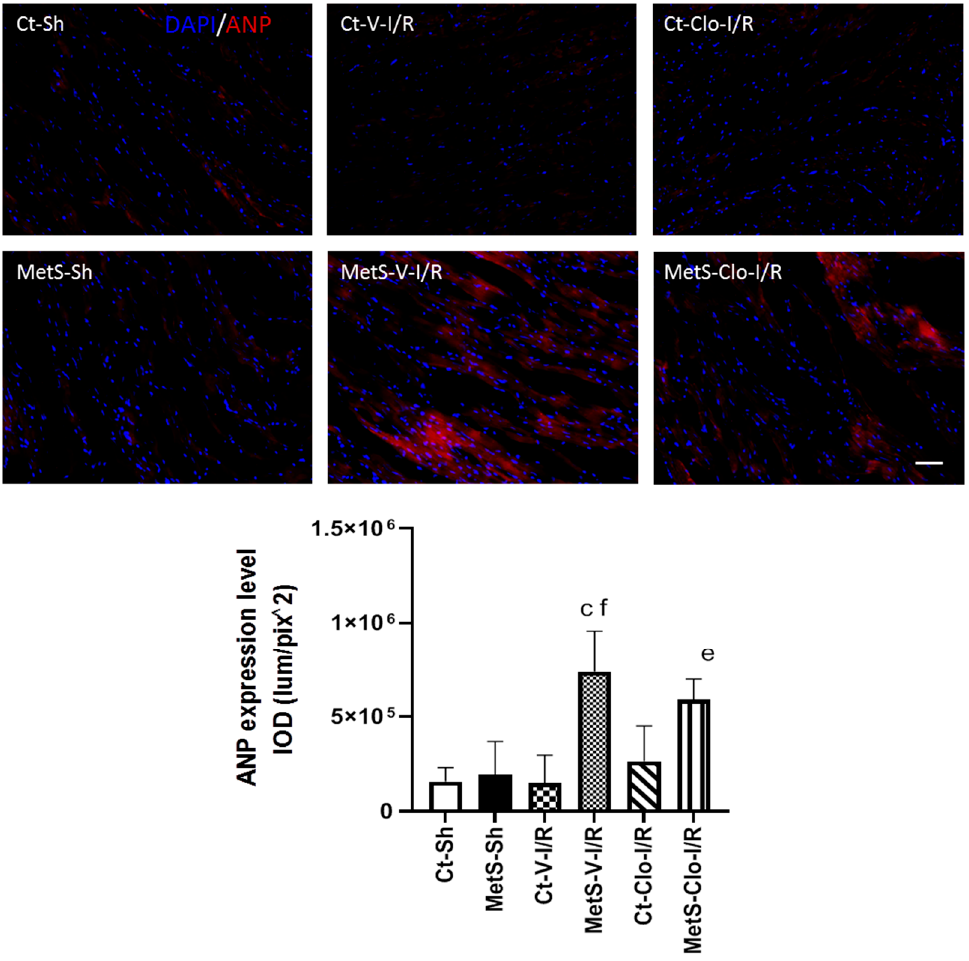
Figure 4. Effect of clofibrate administration on the expression of atrial natriuretic peptide (ANP) in the left ventricles from control and MetS rats. The representative images show the immunodetection of ANP (red) and 2-[4-(Aminoiminomethyl) phenyl]-1H-Indole-6-carboximidamide hydrochloride (DAPI) was used to label the nuclei. The graph showing the expression of immunodetection levels is presented. Data represent mean ± SEM. c p < 0.0001 vs. Ct-V-I/R; e p < 0.0001 vs. Ct-Clo-I/R; f p < 0.0001 vs. MetS-Sh. At least 4 fields of each animal (3 rats per group) were quantified, with a total of at least 12–24 determinations. Abbreviations: Ct = control; MetS = metabolic syndrome; Sh = sham-operated rats; V = vehicle; Clo = clofibrate. Bar = 100 μ m. IOD = integrated optical density, corresponding to ANP expression level.